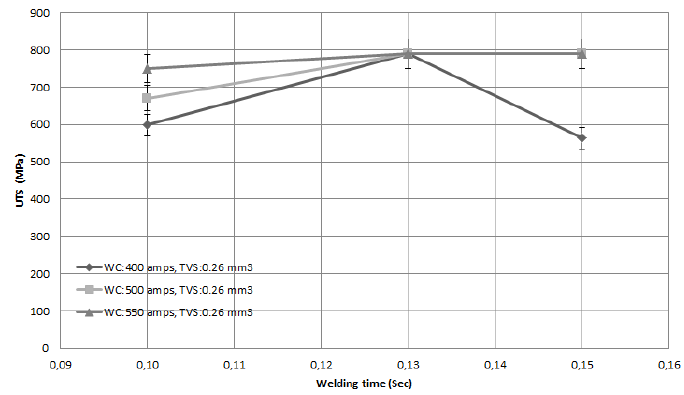
Figure 6. Effect of welding time on ultimate tensile strength.